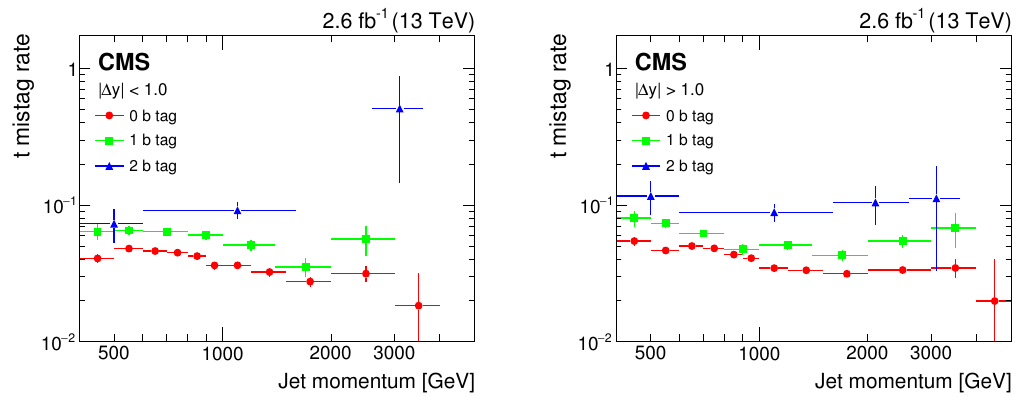
Figure 3 . The mistag rate for the t tagging algorithm in the fully hadronic channel, measured with data for the six event categories by an anti-tag and probe procedure. The round, square, and triangular points indicate the t mistag rate for events in the 0, 1, and 2 b tag categories, respectively. The left (right) plot contains events with j (cid:1) y j < 1 : 0 ( > 1 : 0). The contamination from tt production is removed by subtracting the distribution of tt events in simulation, normalized to SM